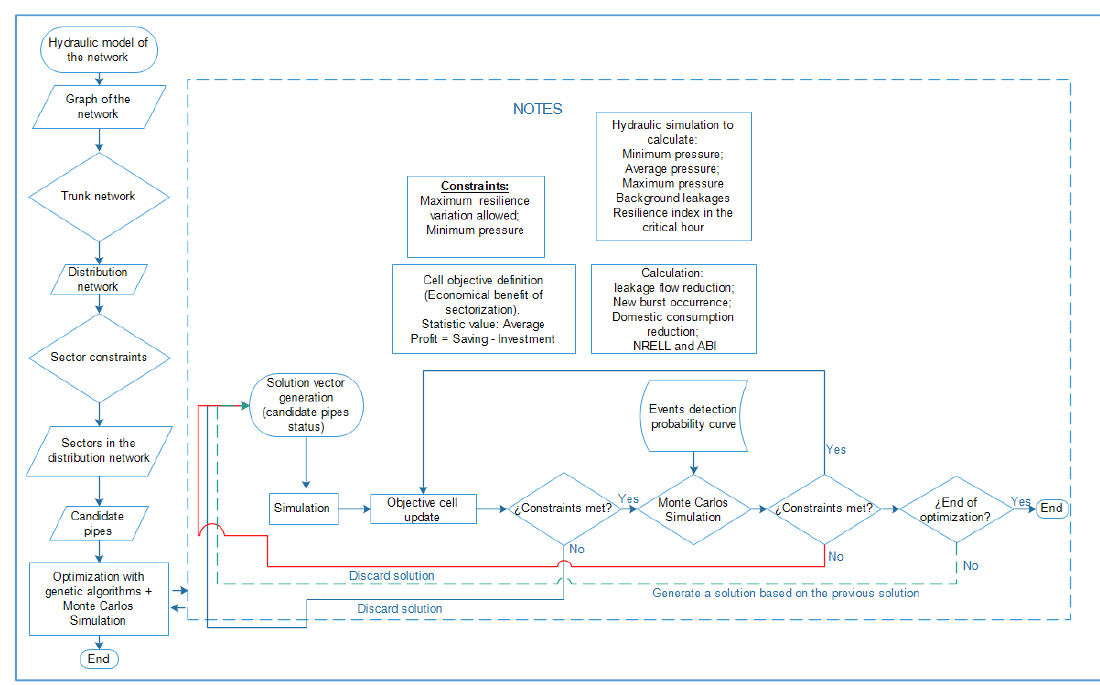
Figure11. Flowchart of the proposed methodology. Figure 11. Flowchart of the proposed methodology.